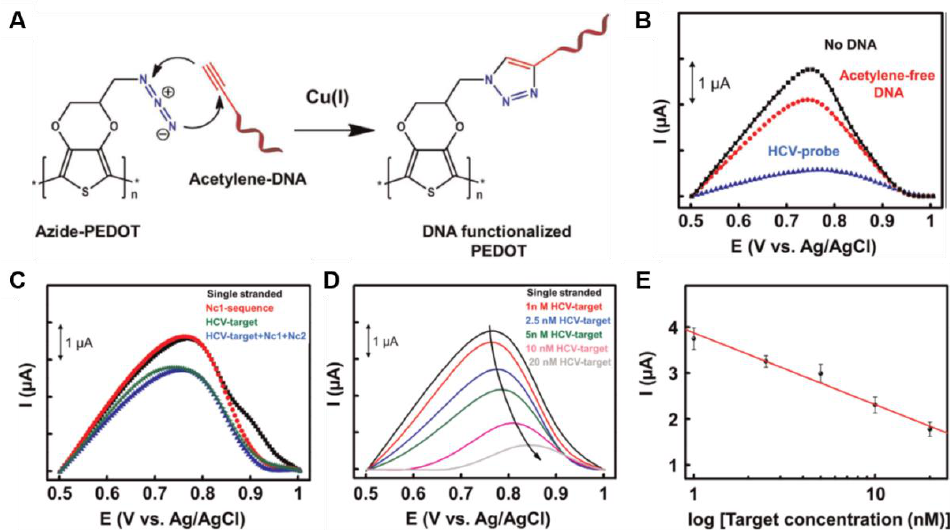
Figure 13. Scheme of the fabrication of DNA immobilization process by “click” reaction ( A ). DPV measurements after “click” reaction ( B ). Selectivity evaluation of the DNA sensor by DPV measurements ( C ) and corresponding calibration curve ( n = 3) ( D ). Adapted with permission from reference [74]. Copyright 2015 Elsevier.